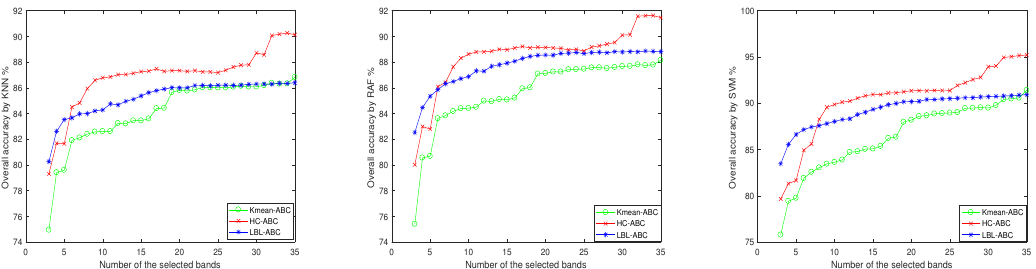
Figure 16. The OA values obtained by K-mean-ABC, HC-ABC, and LBL-ABC on Pavia University.